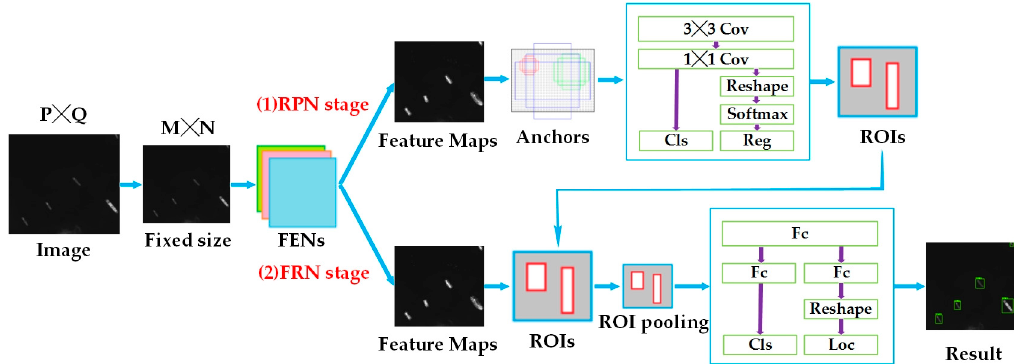
Figure 3. The network structure of the Faster R-CNN-based ship detection method.